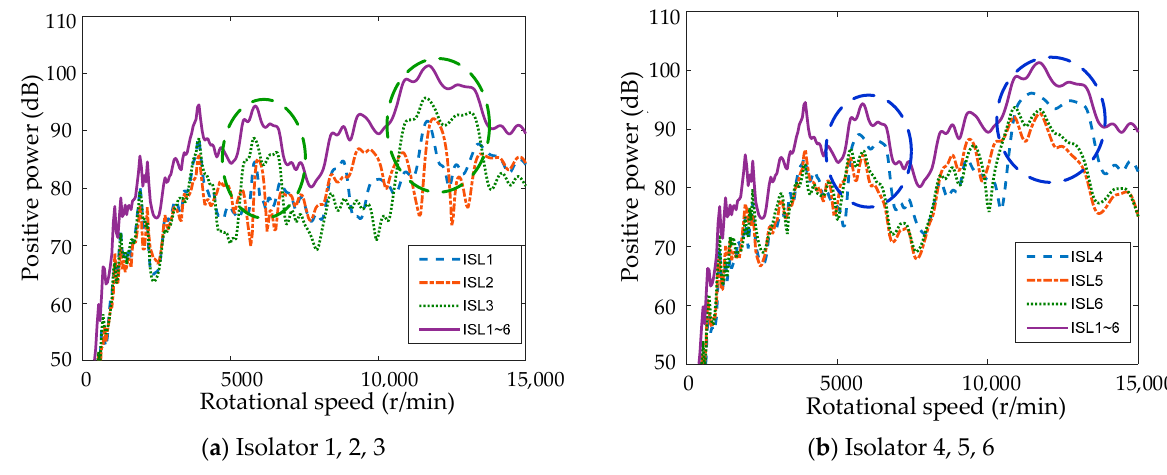
Figure 15. Housing isolator transmitted power—location path. The transmitted power corresponding to the direction path is shown in Figure 16. The direction of power in ux, uy, uz, and roty DOF are constantly positive. There are